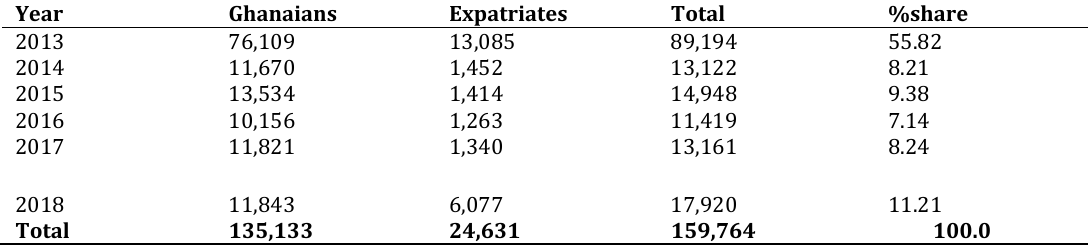
Table 7: Breakdown of FDI total employment to be created from 2013 to